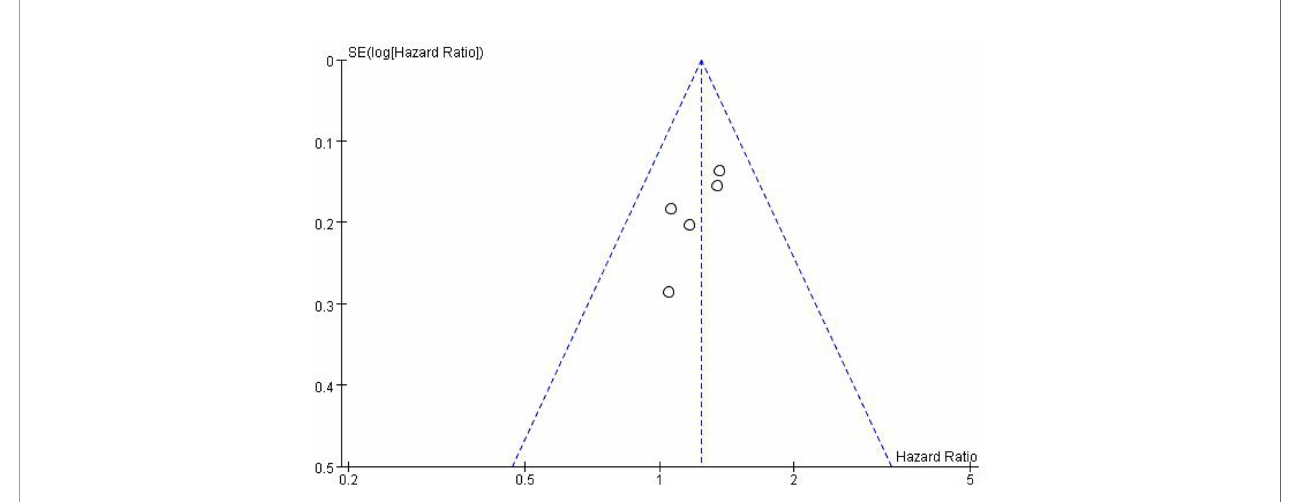
FIGURE 5 | Inverted funnel plot of